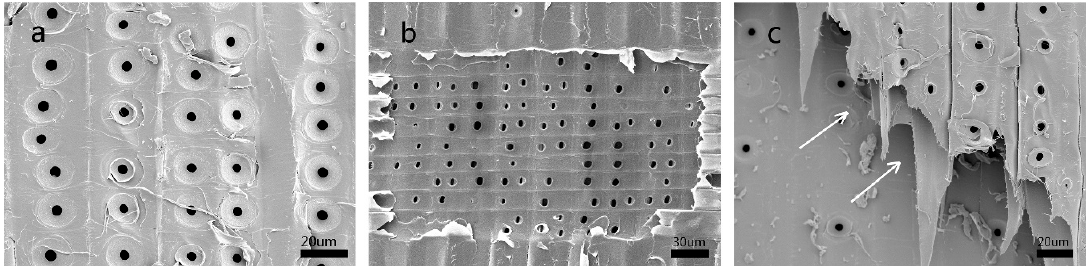
Figure 6. SEM micrographs of fracture surface of macro ‐ cracks in the high ‐ intensity MW ‐ treated sample: ( a ) Bordered pit membranes fell off, ( b ) cross ‐ field pit membranes disappeared and ray parenchyma cells were damaged, ( c ) longitudinal tracheids fractured.